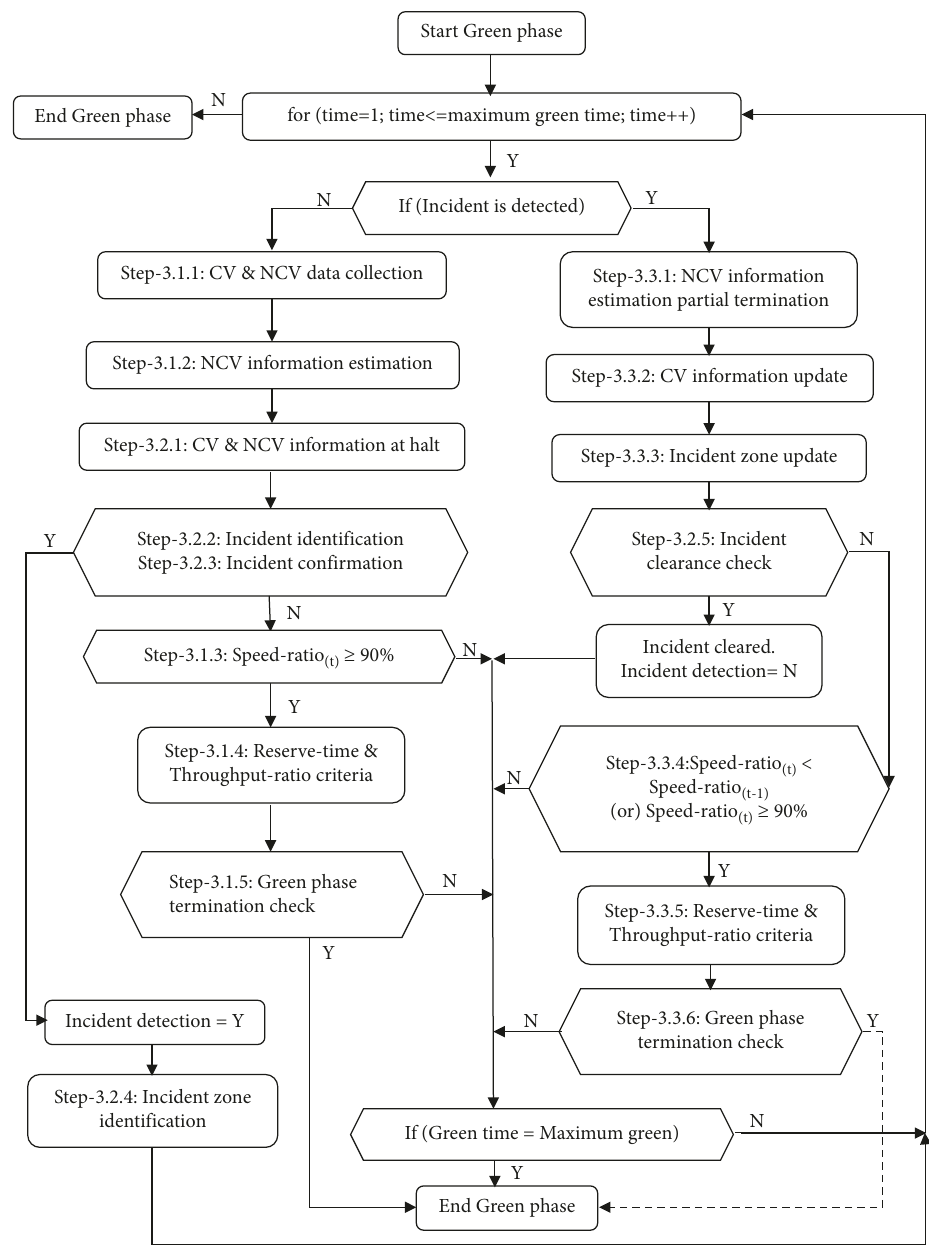
Figure 1: Integrated algorithm of IA-CVSC, incident detection, and IR-CVSC